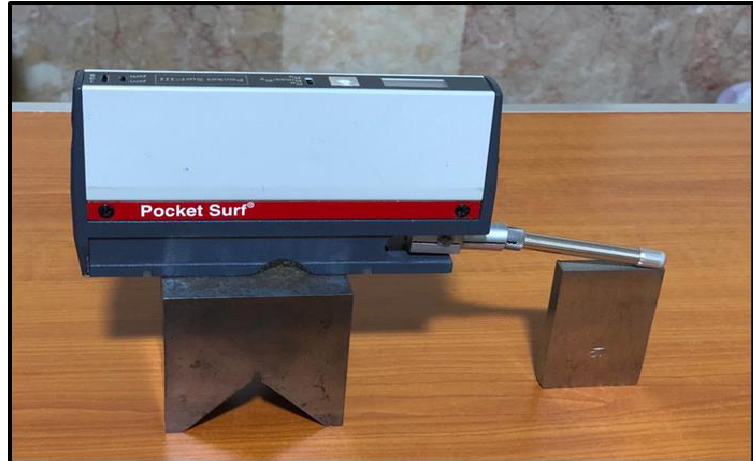
Figure 6: Photo of the Surface roughness measuring